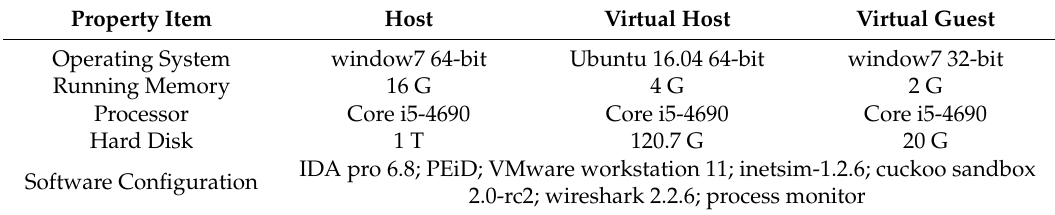
Table 2. Configuration